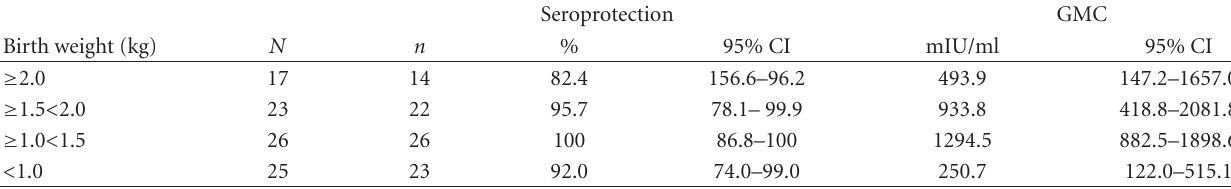
Table 3: Post-primary anti-HBs seroprotection rates and GMCs by birth weight (ATP cohort for immunogenicity).